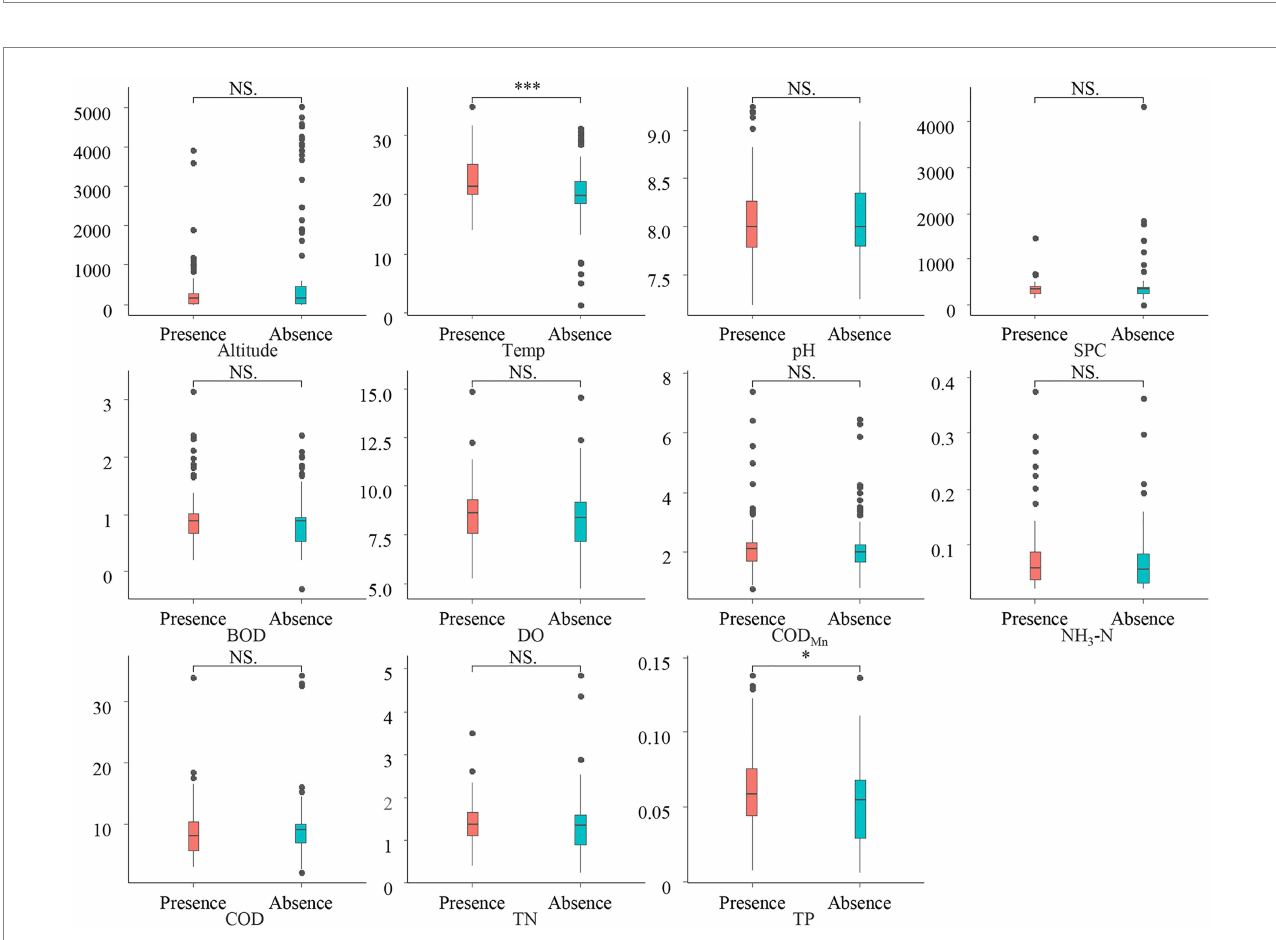
FIGURE 3 Environmental difference between presence/absence sites of colonial volvocine algae. * p < 0.05; *** p < 0.001; NS, Not